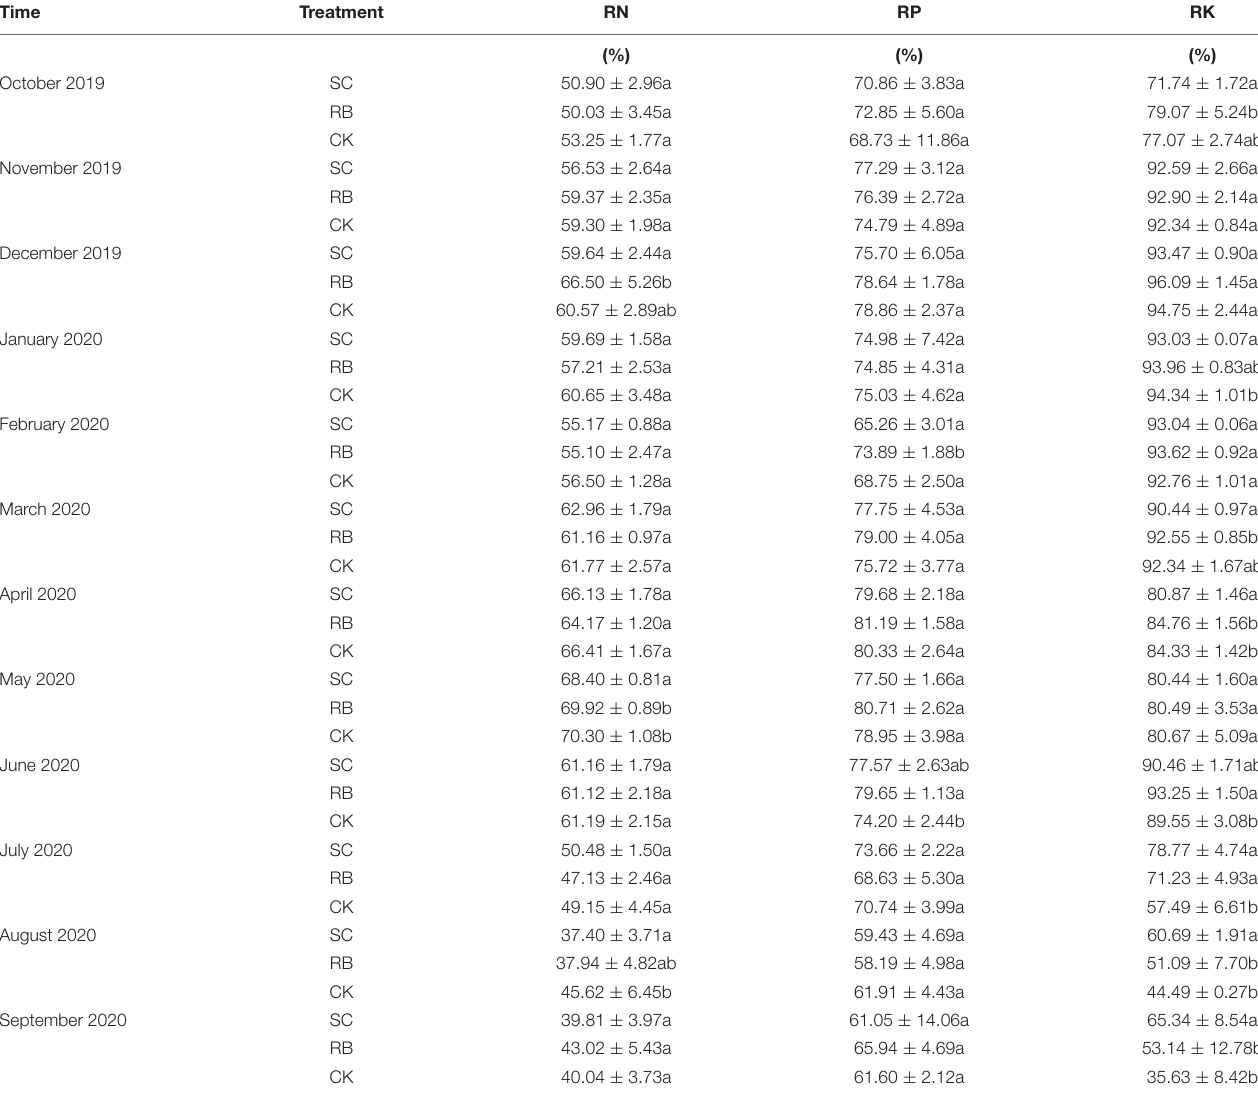
TABLE 2 | Nutrient resorption efficiency of moso bamboo in strip clearcut (SC), reserve belt (RB), and unharvested (CK) plots. Time Treatment